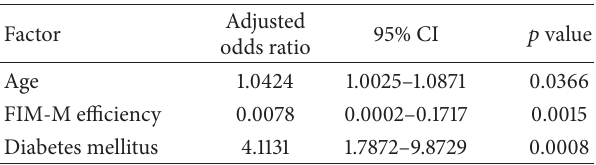
Table 5: Multiple logistic regression analysis of various factors associated with polypharmacy.